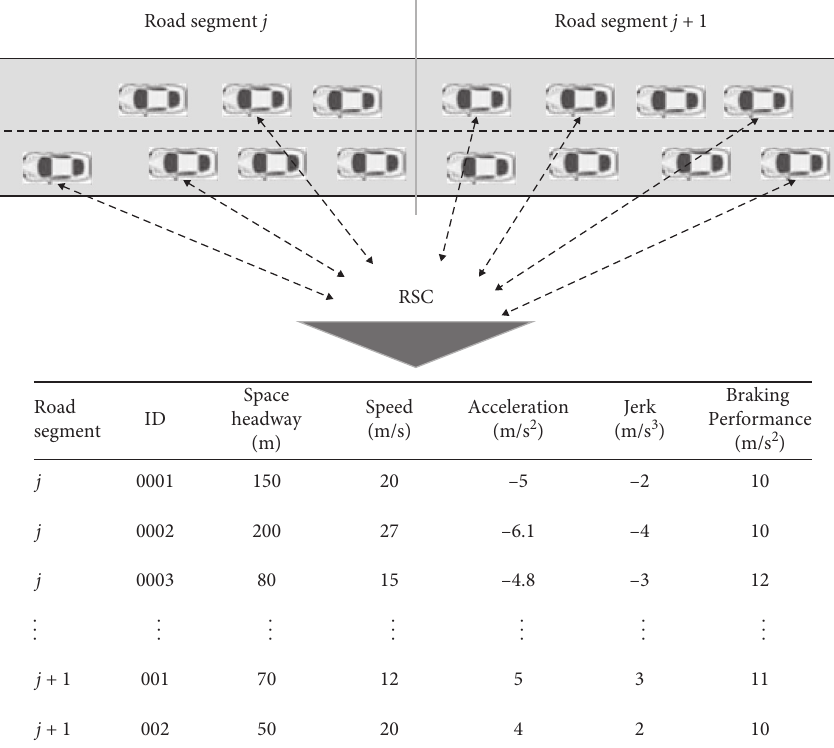
Figure 3: Concept of data gathering method applied in the proposed